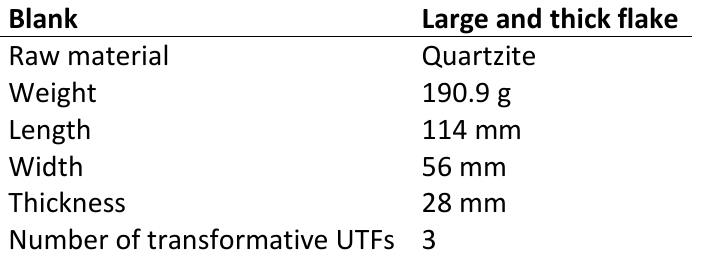
Figure 7. Limace found at Lapa de Taquaraçu archaeological site, Dark arrow represents the absence of platform and bulb in the blank flake. Scale bar is 7 cm. Drawing by João Carlos Moreno da Sousa. Table 2. Artifact main